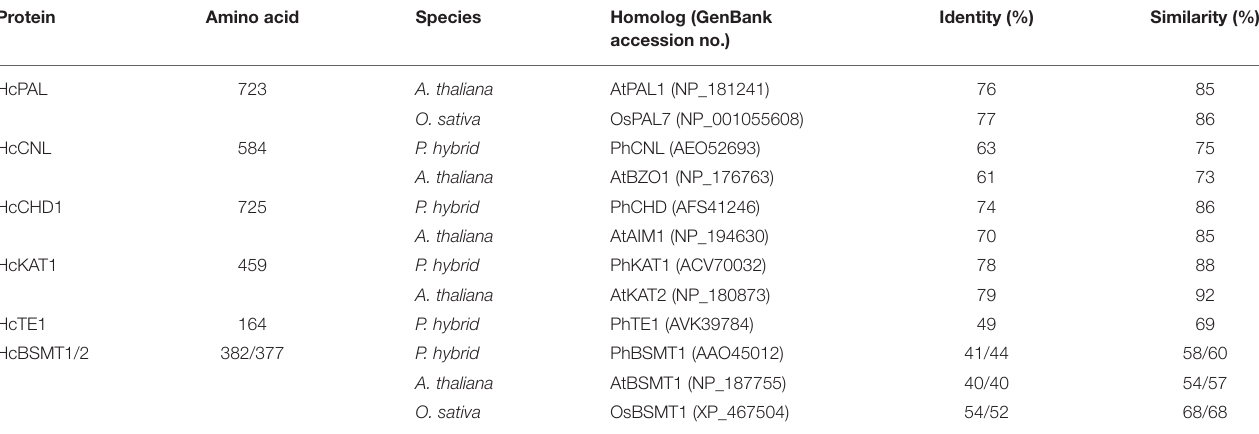
TABLE 1 | Comparison of deduced proteins related to methyl benzoate biosynthesis in H. coronarium with homologs in other plants. Protein Amino acid Species Homolog (GenBank accession